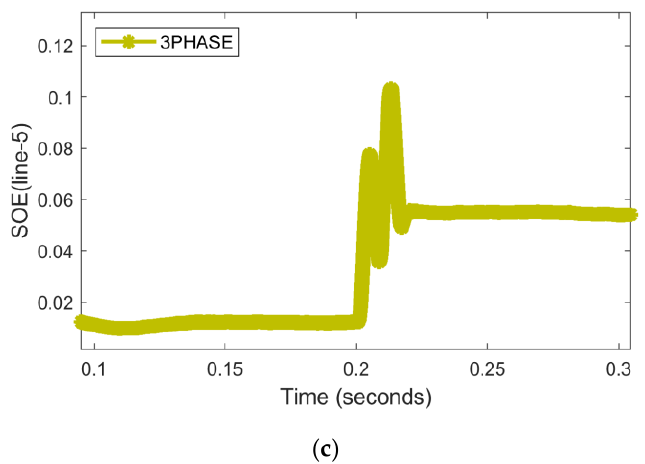
Figure 10. An HI single-fault hits phase B Z L = 70 Ω in TU mode. ( a ) Current signals ( b ) PFD ( c ) RNN-assisted SOE.